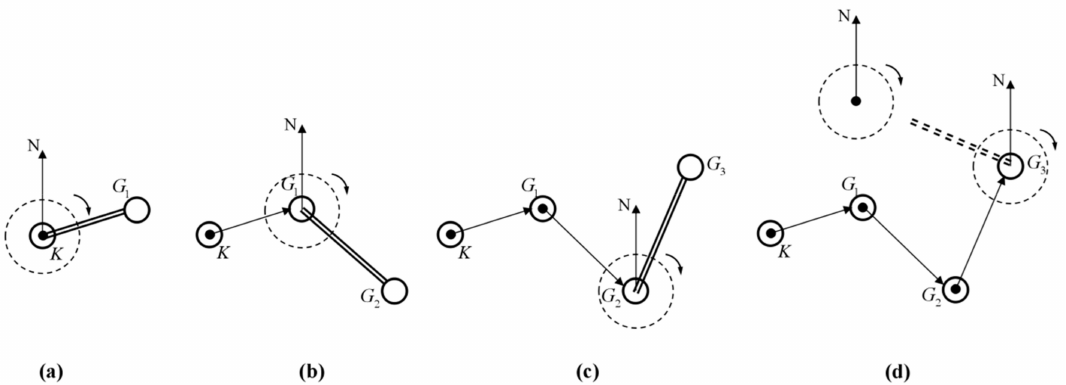
Figure 2. The process of searching and mining subordinate seed tourist sites with the clustering center K or seed tourist site G e as central points. ( a ) The process of mining seed tourist site G 1 with central point K under the control of the algorithm. ( b ) The process of mining seed tourist site G 2 with central point G 1 under the control of the algorithm. ( c ) The process of mining seed tourist site G 3 with central point G 2 under the control of the algorithm. ( d ) The process of mining the seed tourist site with central point G 3 . The subsequent steps are in the same